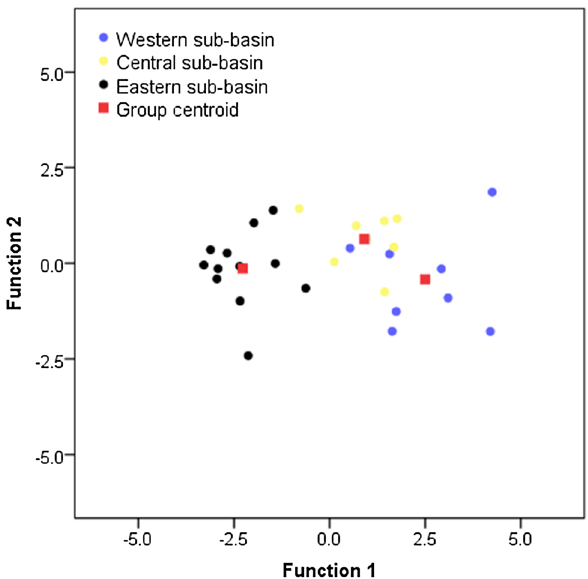
Figure 5. Two-dimensional scatterplot constructed based on the first and second functions of the stepwise DFA for the tracers selected using either TRT + KW + DFA or TRM + KW + DFA.